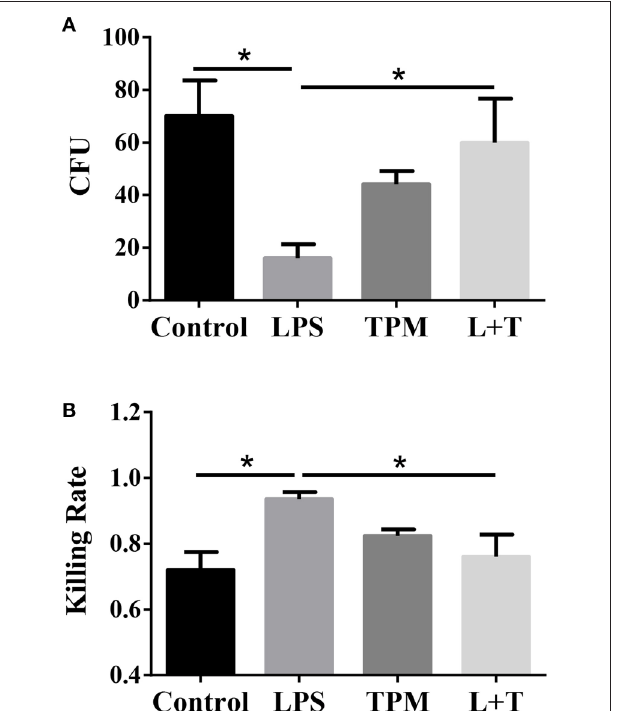
FIGURE 3 | TPM restored mitophagy in neutrophils challenged with LPS. Bone marrow neutrophils were treated with either PBS, LPS (1 µ g/ml) and/or TPM (70ng/ml equi-nicotine units) for 24h. Cells were fixed and co-stained with fluorescently-conjugated anti-COX4 (mitochondria marker) antibody as well as anti-LAMP1 (lysosome marker) antibody. Cells were visualized by confocal microscopy.